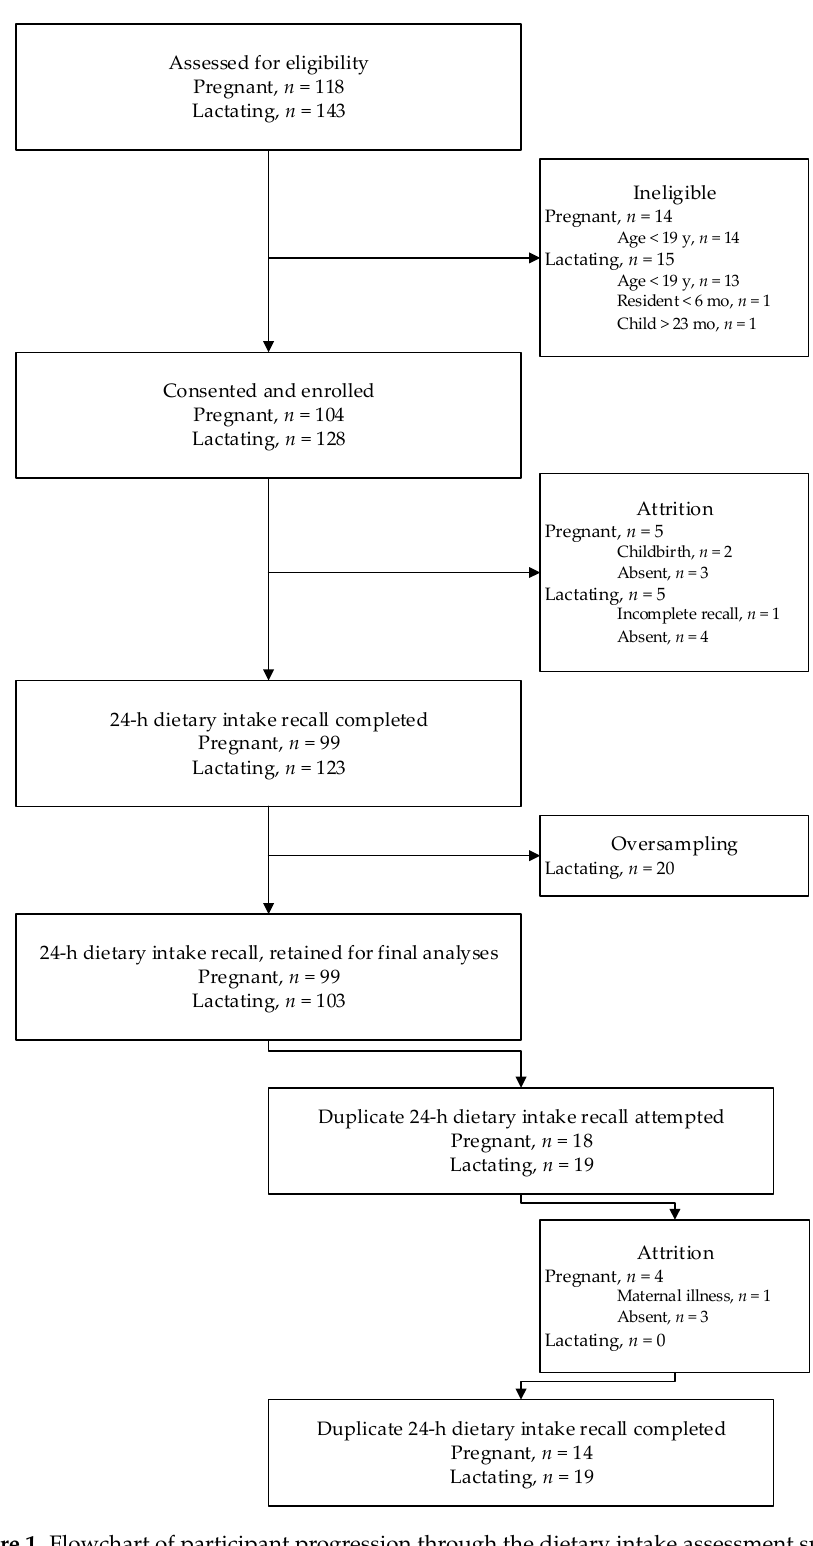
Figure 1. Flowchart of participant progression through the dietary intake assessment survey.